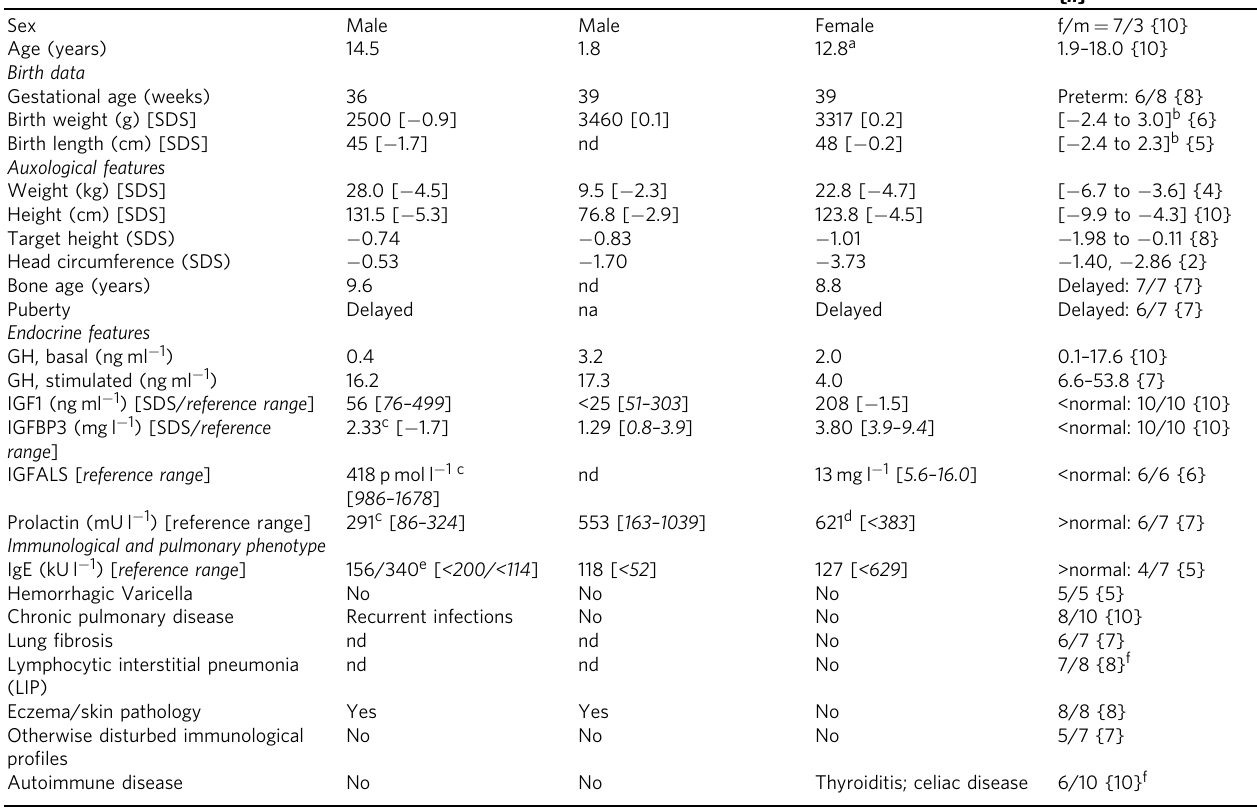
Table 1 Clinical characteristics of autosomal-dominant STAT5B-de fi cient index patients and comparison to previously reported autosomal-recessive STAT5B